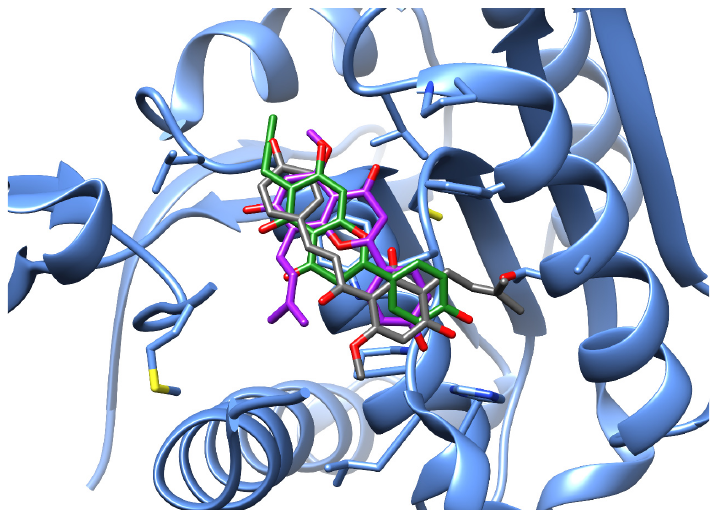
Figure 5. Comparison of the docked xanthohumol (gray), isoxanthohumol (purple), and 6-prenylnaringenin (green) to the acyl-protein thioesterase 2 (PDB ID 5syn). All docked molecules lie within the same binding pocket. The protein is depicted in a blue cartoon model.